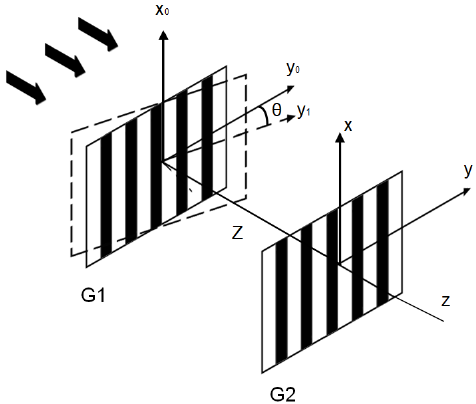
Figure 1. Schematic of the two-grating structure. G1 is the upper grating. G2 is the lower grating. G1 twisted around the x 0 axis with a pitch angle of θ .